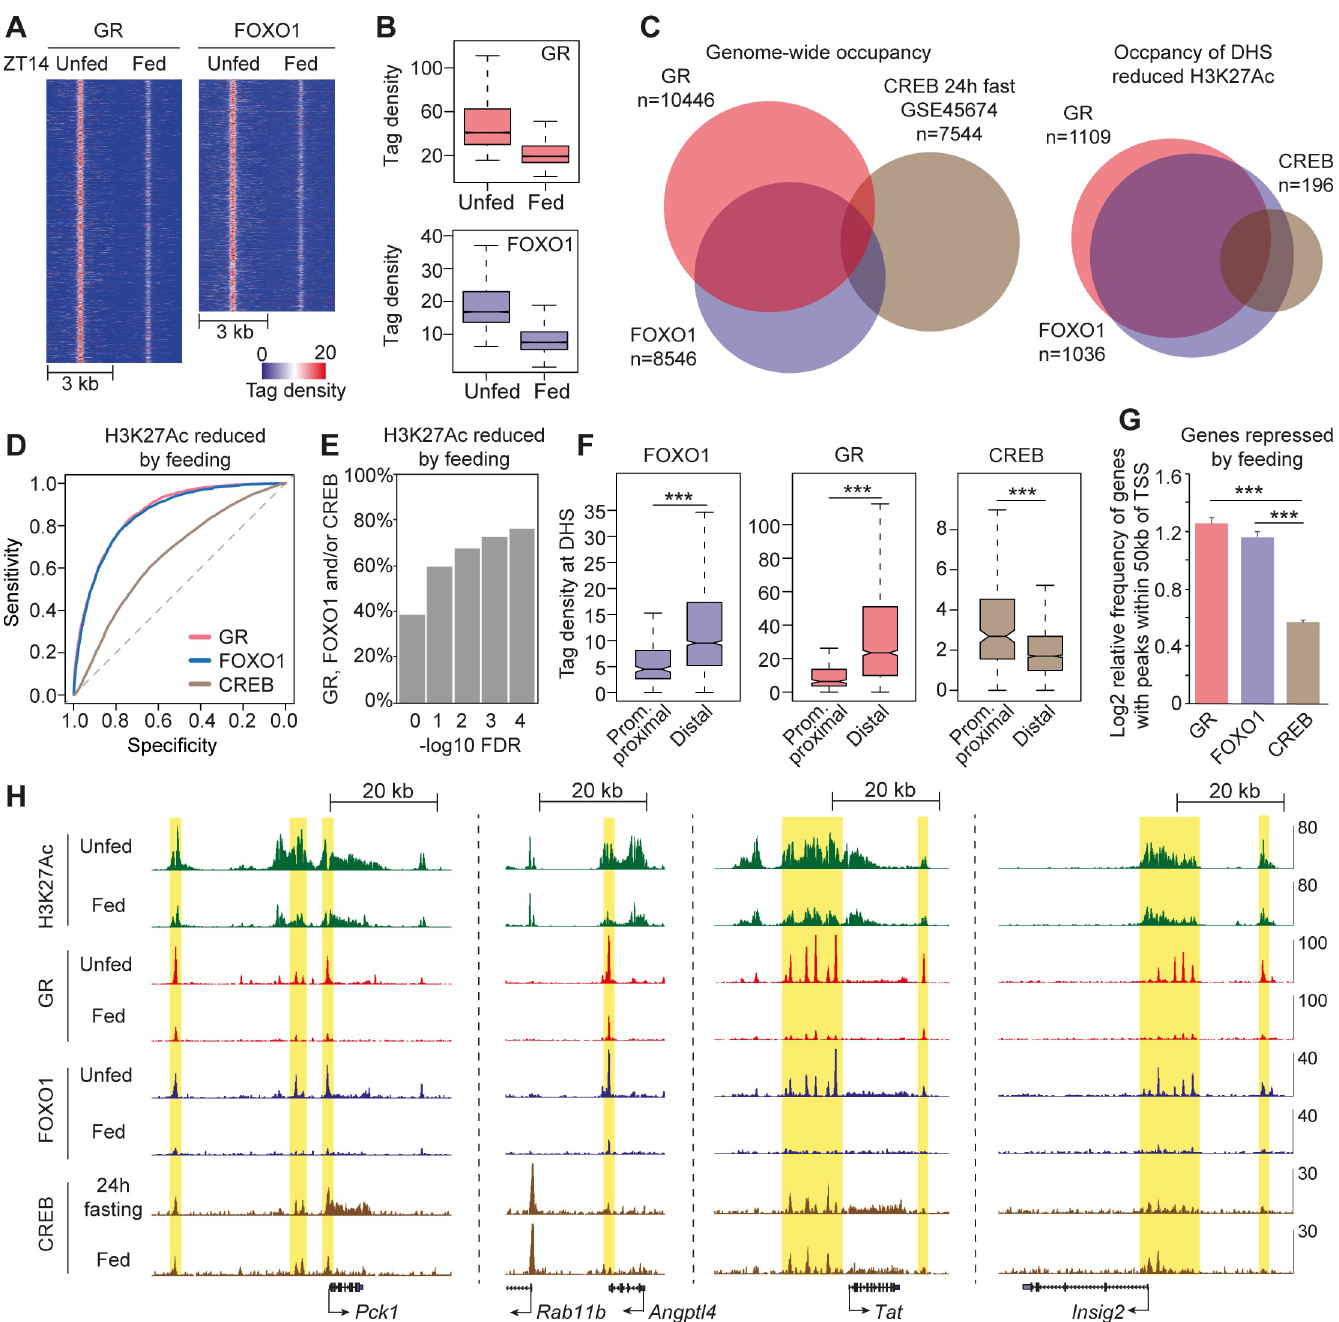
Fig 4. Pre- and postprandial occupancy of GR and FOXO1. GR and FOXO1 ChIP-seq was performed on livers isolated from mice euthanized at ZT14-unfed and ZT14-fed. Replicate concordant GR and FOXO1 peaks were identified in unfed mice. (A and B) Tag density of hepatic GR ( n = 10,446) and FOXO1 ( n = 8,546) ChIP- seq in unfed and fed conditions. (C) Co-occupancy of GR, FOXO1, and CREB genome wide (left) and at DHSs surrounded by feeding-reduced H3K27Ac (right). CREB ChIP-seq data is from Everett and colleagues [31]. (D) ROC analysis of GR, FOXO1, and CREB occupancy within DHS surrounded by H3K27Ac reduced by feeding at FDR < 0.05. (E) Percentage of DHSs surrounded by feeding-reduced H3K27Ac occupied by GR, FOXO1, and CREB. DHSs associated with feeding-regulated H3K27Ac was scored at different FDRs ( n = 3). (F) Tag density of FOXO1, GR, and CREB ChIP-seq at DHSs surrounded by feeding-reduced H3K27Ac located promoter proximal (1 kb upstream the TSS) or distal to the TSS ( > 1 kb from TSS). Statistical significance is calculated using a Mann–Whitney–Wilcoxon test. (G) Frequency of feeding-repressed genes with at least one GR, FOXO1, or CREB peak within 50 kb of the TSS. Frequency is relative to GR, FOXO1, and CREB binding within 50 kb of TSS of sets of 300 randomly selected genes. Data are presented as mean ± SEM ( n = 6). Statistical significance is calculated using Student t test. (H) Examples of GR, FOXO1, and CREB enrichment within enhancers repressed by feeding. ��� p < 0.001. Numerical values for panels A–G are available in S4 Data. Bed graphs in panel G are available at GEO: GSE119713. ChIP, chromatin immunoprecipitation; CREB, cAMP responsive element binding protein; DHS, DNase